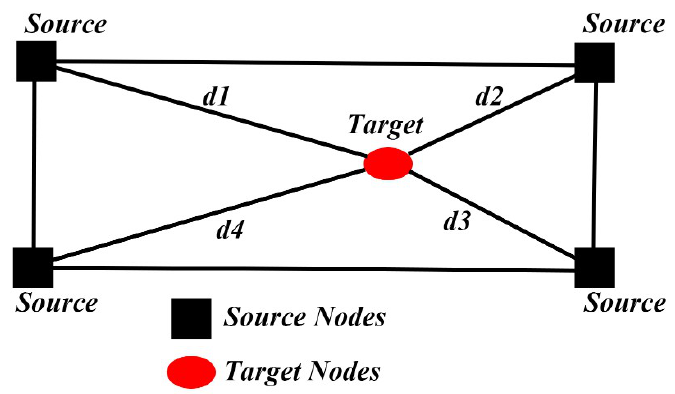
Figure 15. The diagram of the geometric interpolation algorithm.